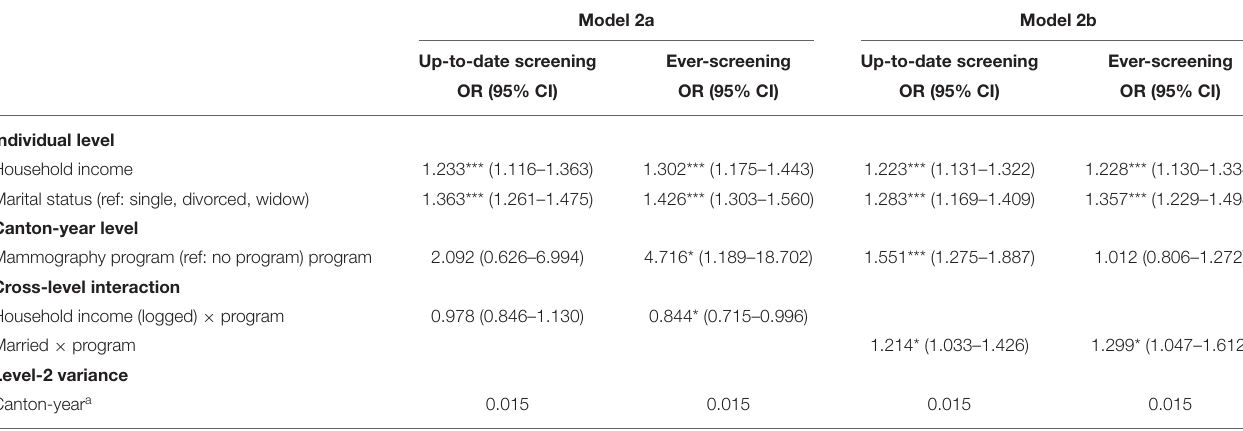
TABLE 2 | Cross-level interactions between mammography program and individual-level variables in their effect on mammography uptake, results of logistic multilevel analysis, odds ratios and confidence intervals ( n individual = 14,267; n canton − year =